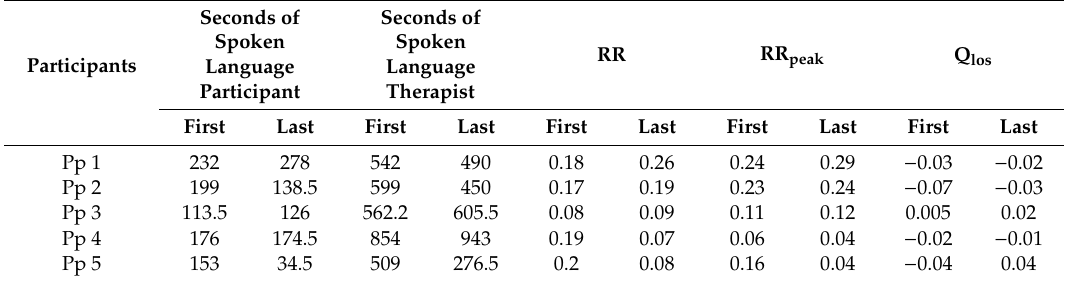
Table 3. Total time of spoken language measured in seconds and DCRP measures for the five cases.